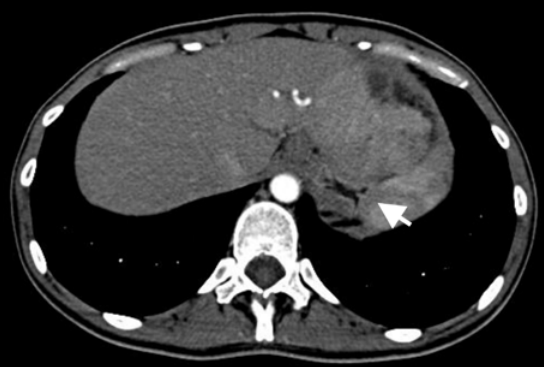
Figure 4. Hepatic arterial phase CT scan shows a large mass with intense heterogeneous enhancement. An afferent vessel that supplies the tumor is clearly visible.